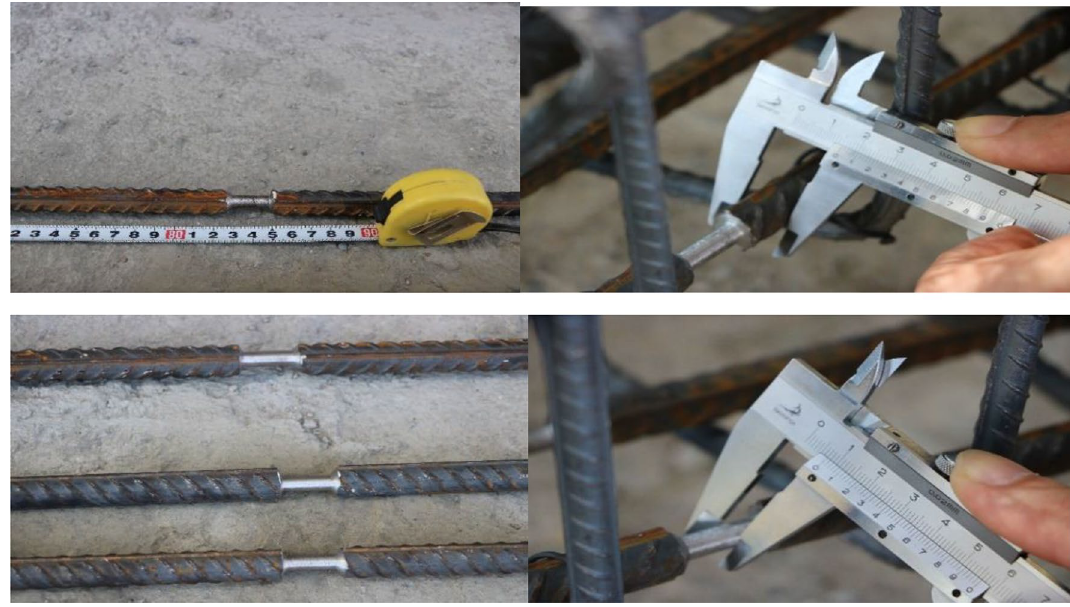
Fig. 3 Longitudinal and transverse rebars and their